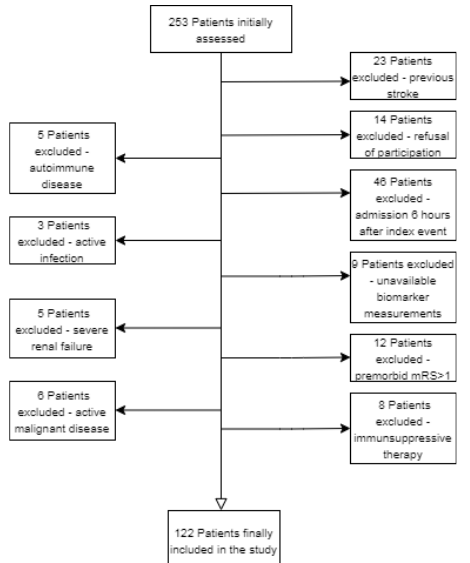
Figure 1. Flow chart illustrating excluded and included patients with acute ischemic